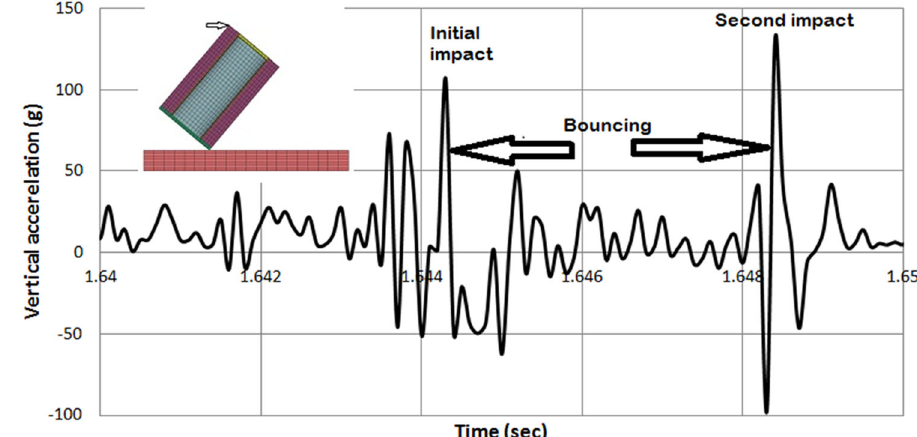
Fig. 20 Time history of vertical acceleration at selected node for the model